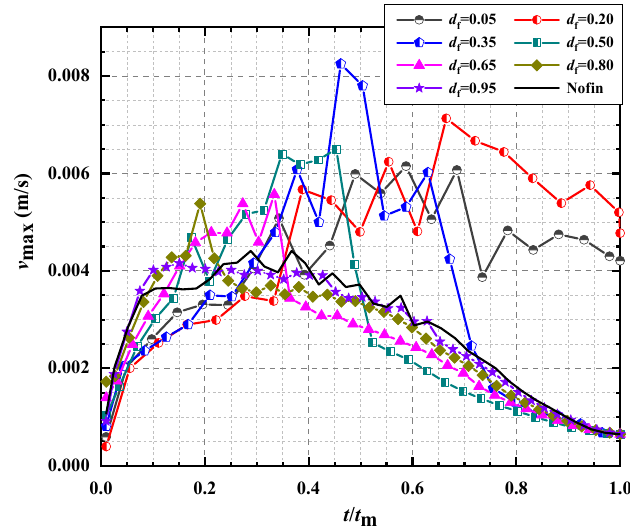
Figure 10. Variation of v max with t/t m for different d f and no fin case.